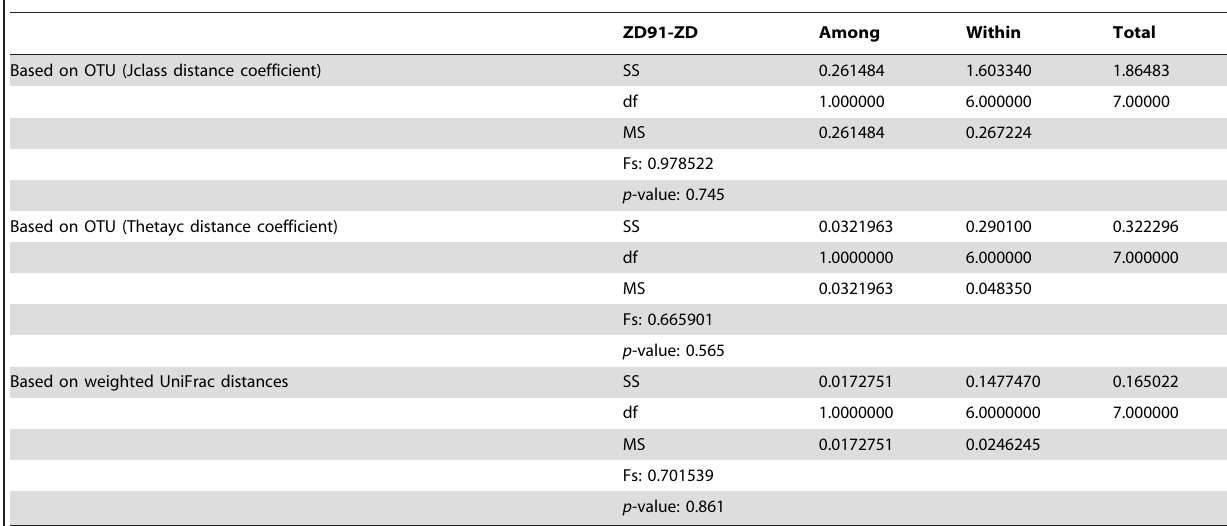
Table 4. AMOVA analysis between ZD and ZD91.